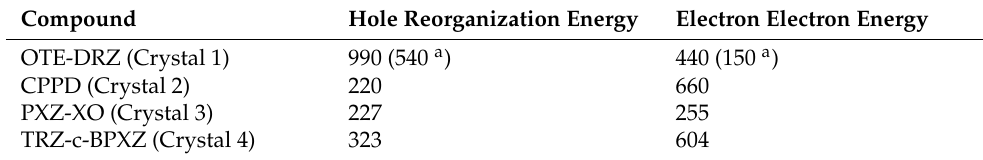
Table 2. Reorganization energies for hole and electron transfer in the crystals studied (in meV). Compound Hole Reorganization Energy